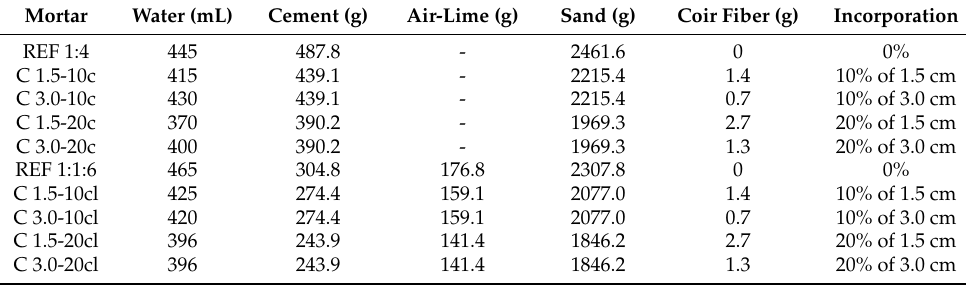
Table 2. Composition of the mortars mixes by